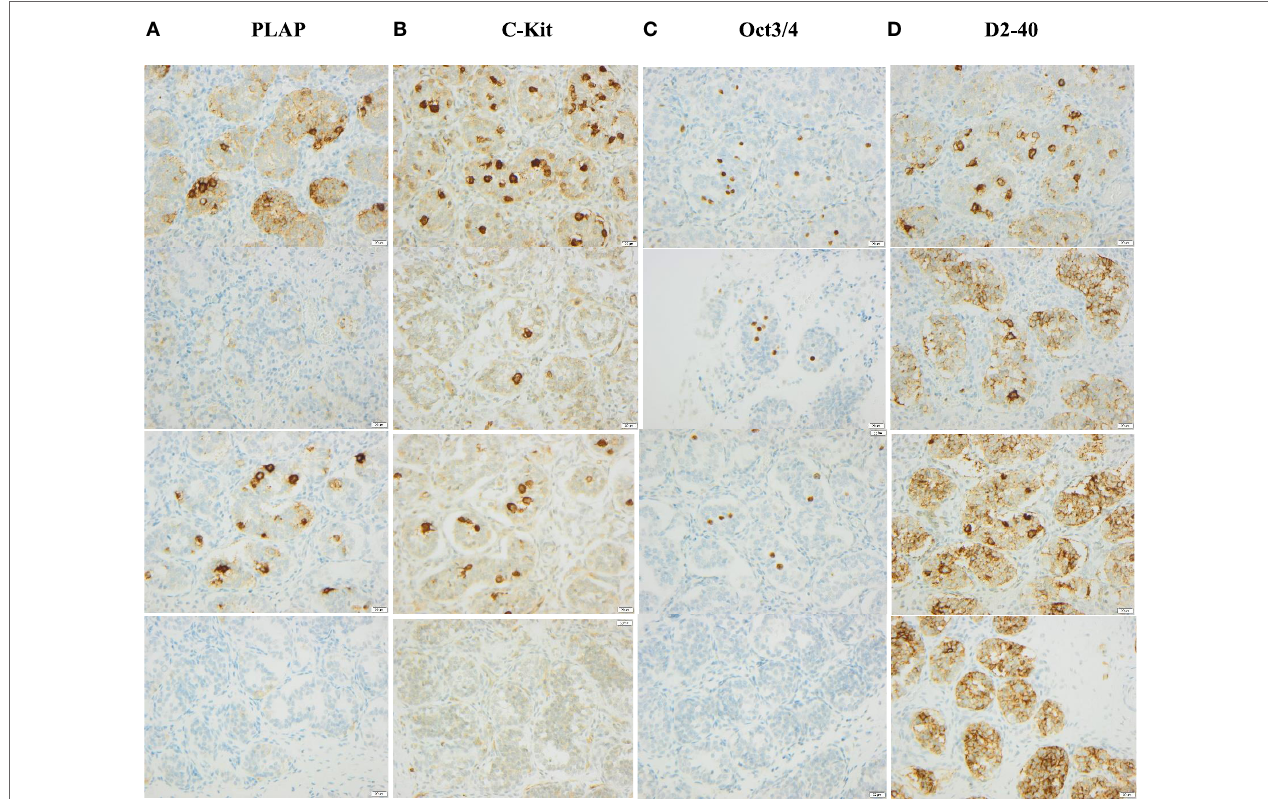
FigUre 2 | Examples of staining for immunohistochemical markers in testicular biopsies of boys 10, 30, 60, and 660 days old, respectively. Column A shows PLAP staining in age order starting with the youngest age in upper row. Column B shows C-Kit staining in the same age order. Column C shows Oct3/4 staining in the same age order. Column D shows D2–40 staining in the same age order.